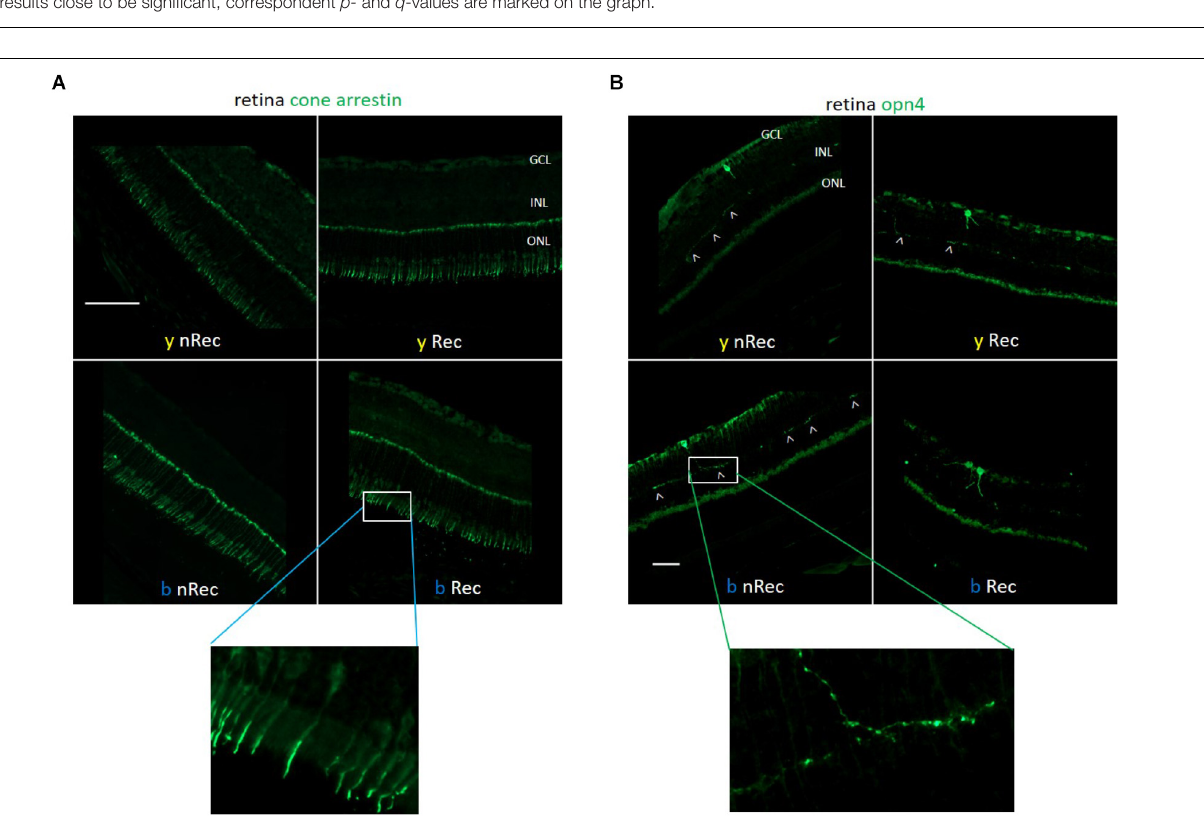
FIGURE 7 | Role of retinal photoreceptors (1). Immunohistochemistry was performed on the retinas of blue- ( b ) and yellow-exposed ( y ) mice either immediately after illumination ( nRec ) or in 3 days of recovery ( Rec ). Results of anti-Cone Arrestin (A) and anti-opn4 (B) stainings are presented. Insets with higher zoom are provided. Magnification is 20 × (A) and 10 × (B) , scale bars correspond to 100 µ